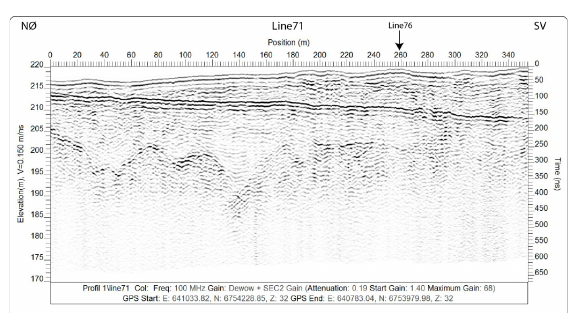
Figure 10: Example of profiles for ground geophysics.